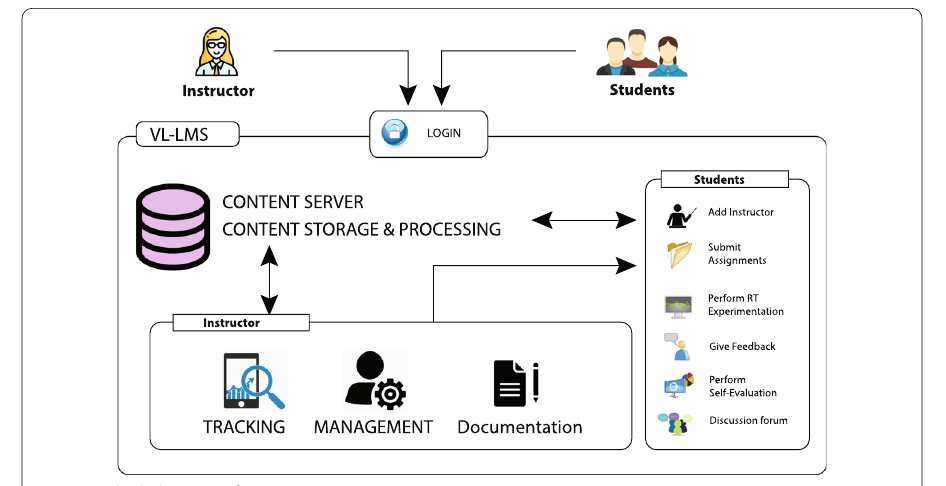
Fig. 11 Block diagram of VL-LMS